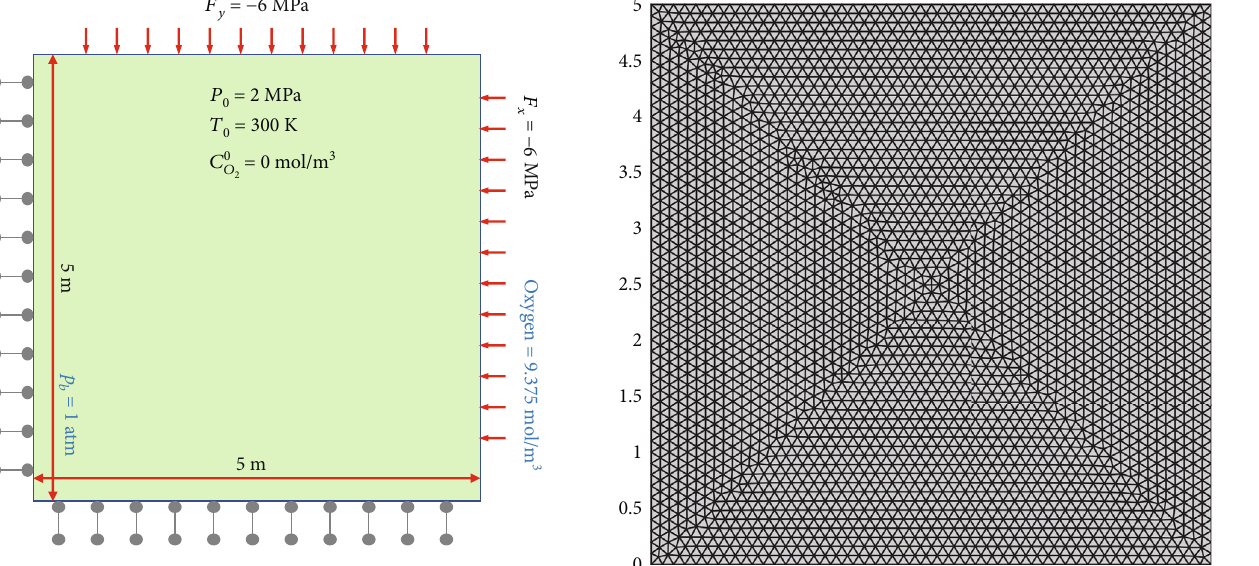
Figure 1: Geometric con fi gurations with initial and boundary conditions.